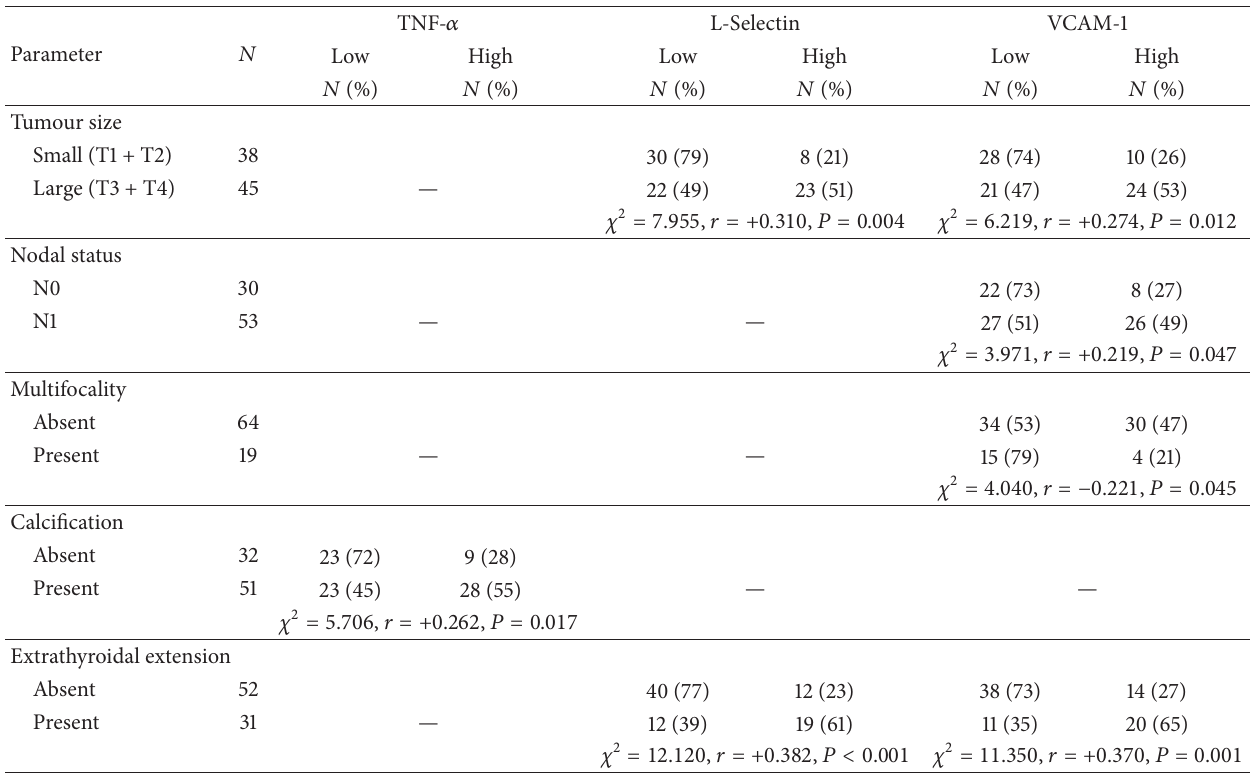
Table 4: Comparison of expressions of TNF- 𝛼 , L-Selectin, and VCAM-1 between the patients with benign thyroid diseases and PTC. Patients TNF- 𝛼 L-Selectin VCAM-1 𝑁 (%) Low High Low High Low High 𝑁 (%) 𝑁 (%) 𝑁 (%) 𝑁 (%) 𝑁 (%) 𝑁 (%) Benign thyroid diseases 45 36 (80) 9 (20)